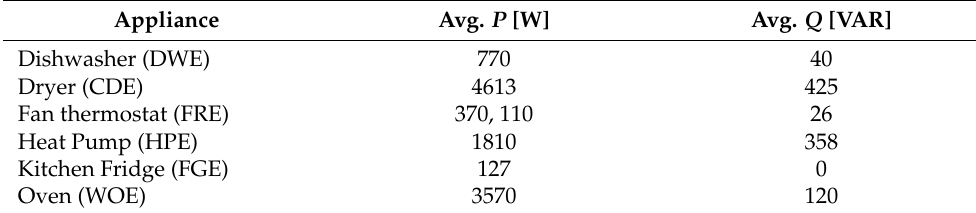
Table 4. Power Estimation for Devices (AMPds